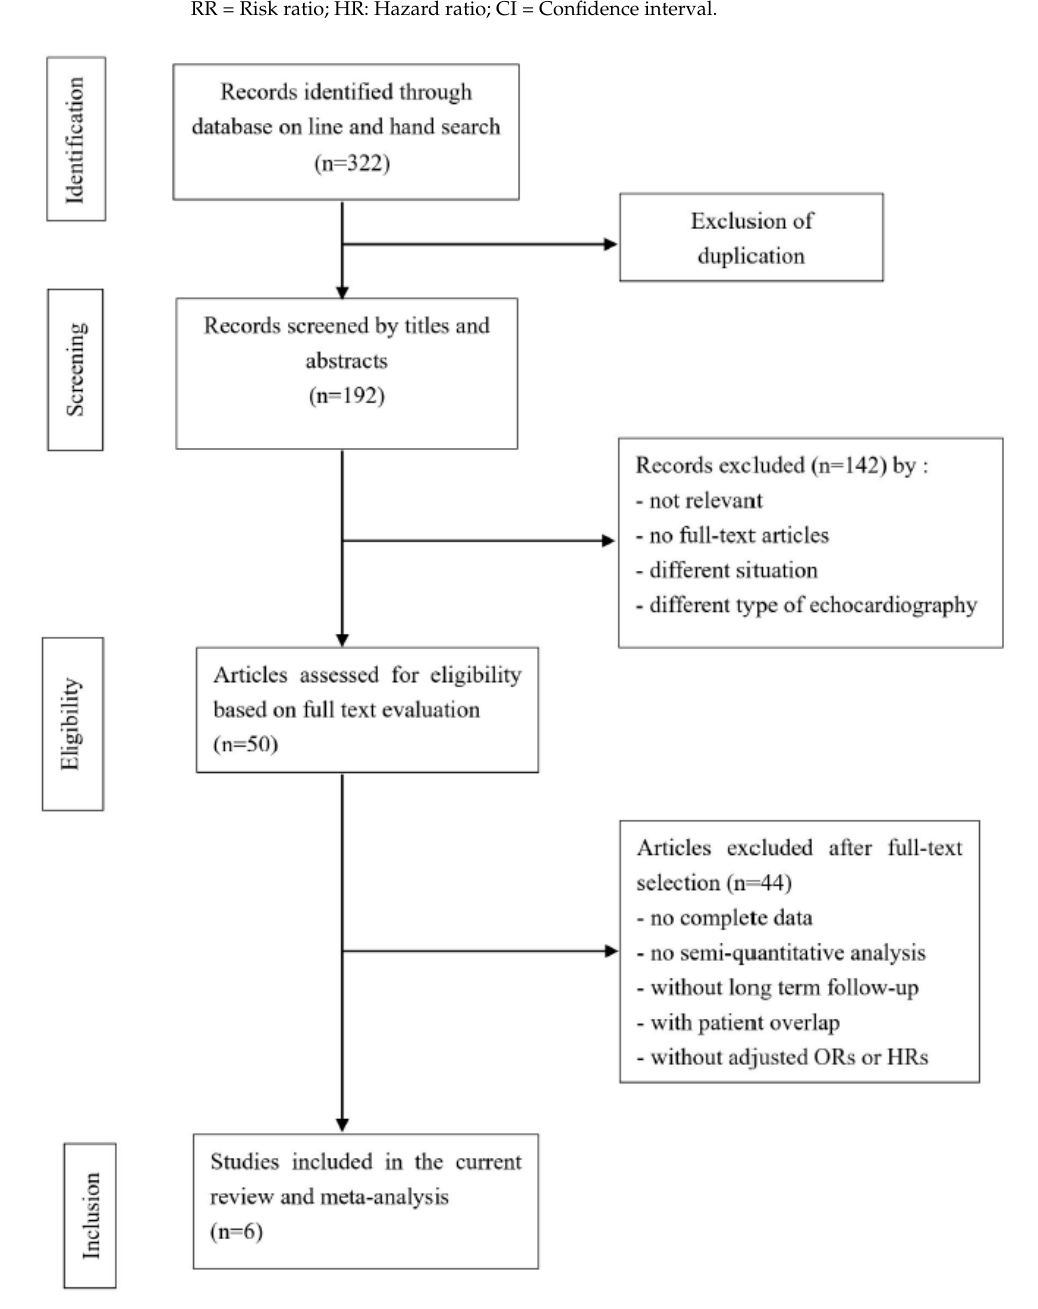
Figure 1. Flowchart of the study selection process.